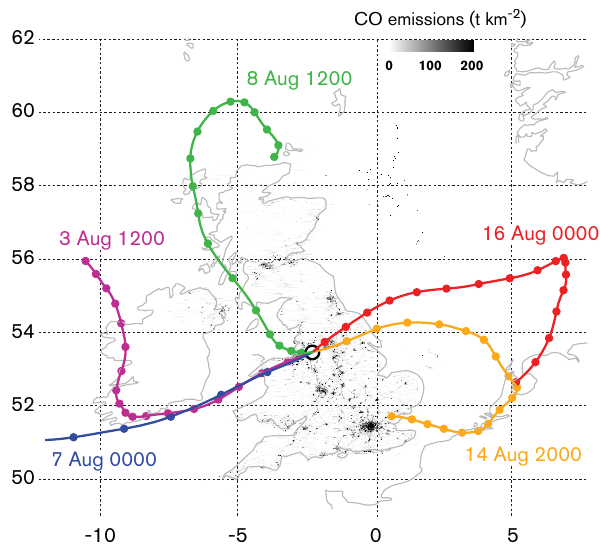
Fig. 5. Selected air parcel backwards trajectories computed from the NOAA HYSPLIT model (Draxler and Rolph, 2010) during am- bient Manchester sampling in 2010 superimposed on the UK Na- tional Atmospheric Emissions Inventory carbon monoxide emis- sions inventory for year 2008. The arrival date and time of each trajectory is indicated and points are separated by three